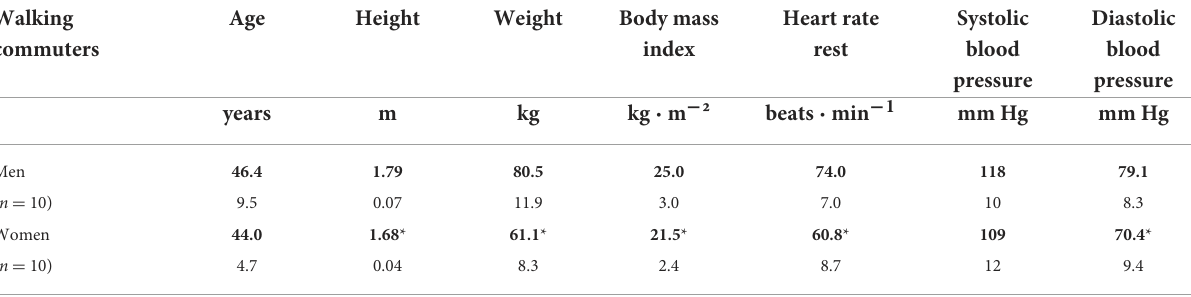
TABLE 1 Characteristics of the walking commuters (mean and standard deviation, SD). Walking